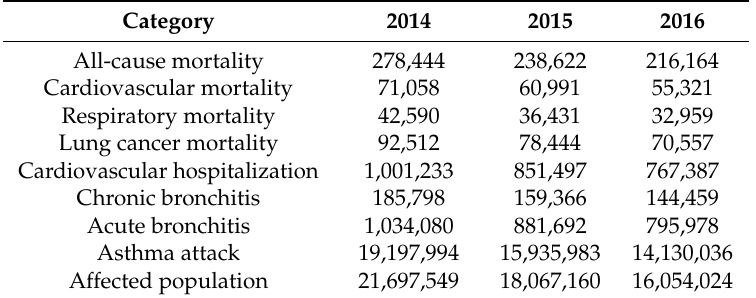
Table 1. Health impacts attributed to PM 2.5 pollution in China during the period 2014–2016.